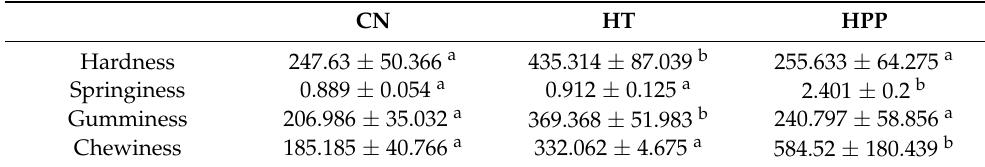
Table 1. Texture results of three